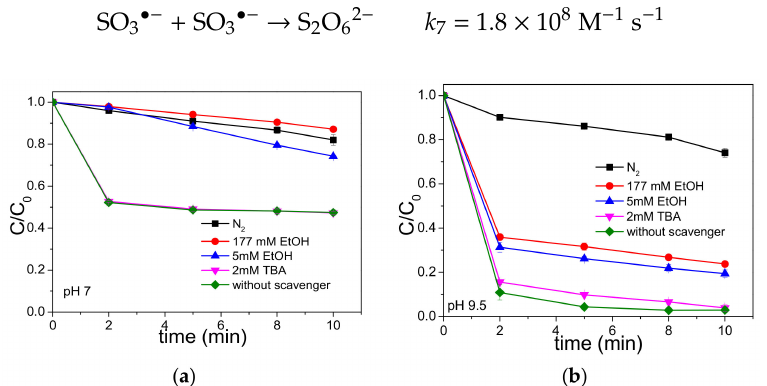
Figure 2. As(III) oxidations in solutions containing scavengers for the relevant radicals generated by UVC-S(IV)-O 2 system at ( a ) pH 7 and ( b ) 9.5. Initial conditions: [S(IV)] 0 = 2 mM, [As(III)] 0 = 5 µ M, [tert.-butylalcohol(TBA)] 0 = 2mM,[EtOH] 0 = 5or177mM.TheflowrateofN 2 wasabout500 mL min − 1 . Except for the N 2 experiments, other results were obtained under aerobic conditions by constantly pumping synthetic air into the